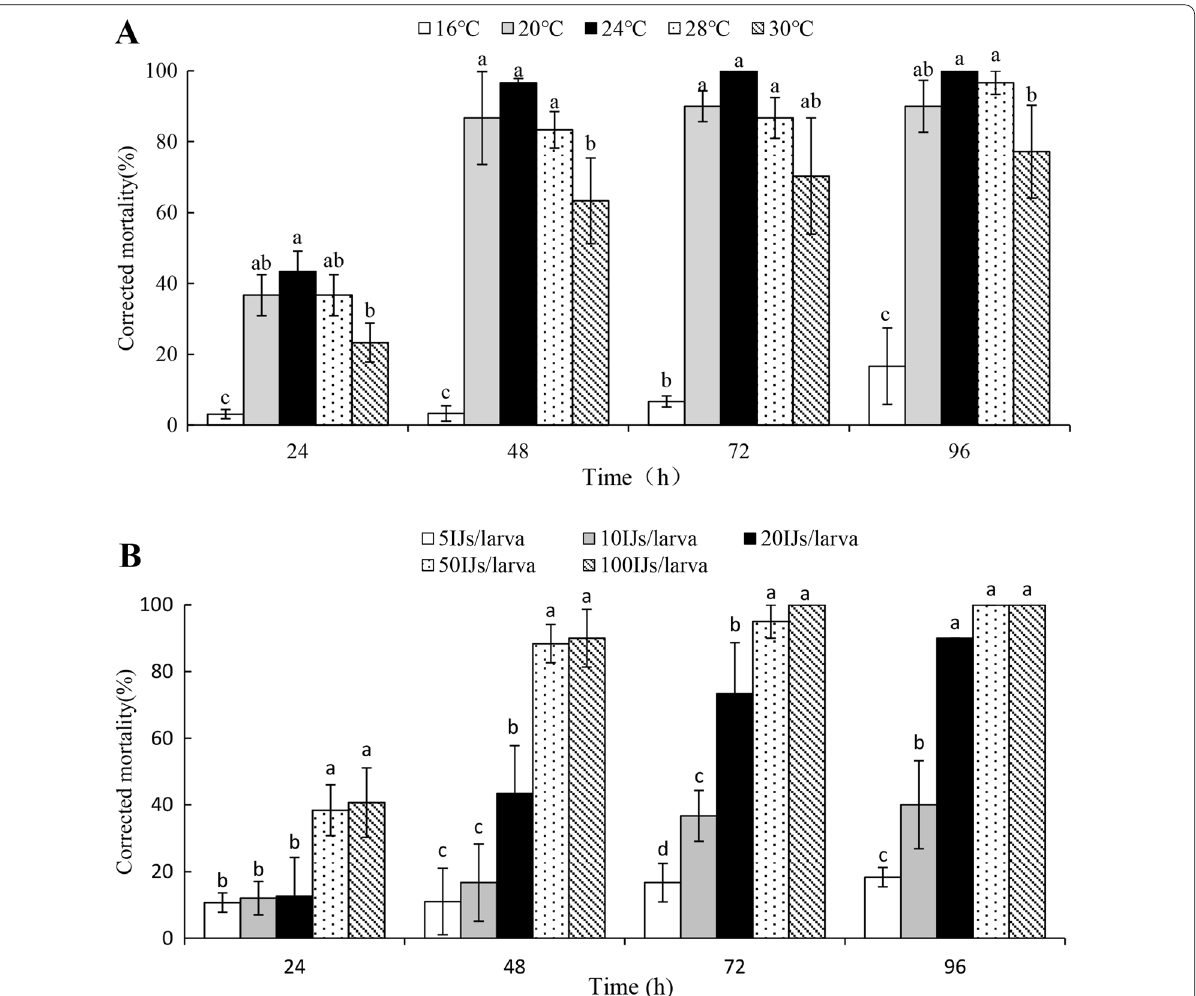
Fig. 4 Screening the optimal infection conditions of Sgib nematodes against Atrijuglans hetaohei . A Corrected mortality of A. hetaohei larvae after exposure to different temperature. B Corrected mortality of A. hetaohei larvae after exposure to different nematodes concentration. Differing letters indicate values significantly different from one another at the p < 0.05 level (Tukey’s HSD